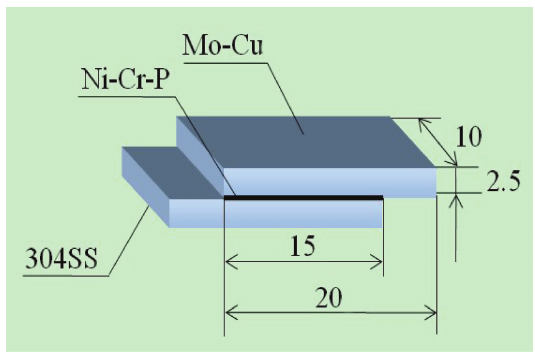
Fig. 1: Schematic diagram of joint assembly (unit in mm)